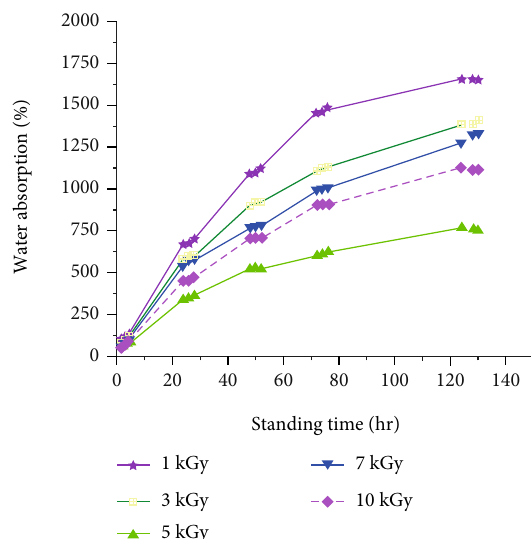
Figure 6: The e ff ect of radiation dose and standing time on water absorption of UHG.